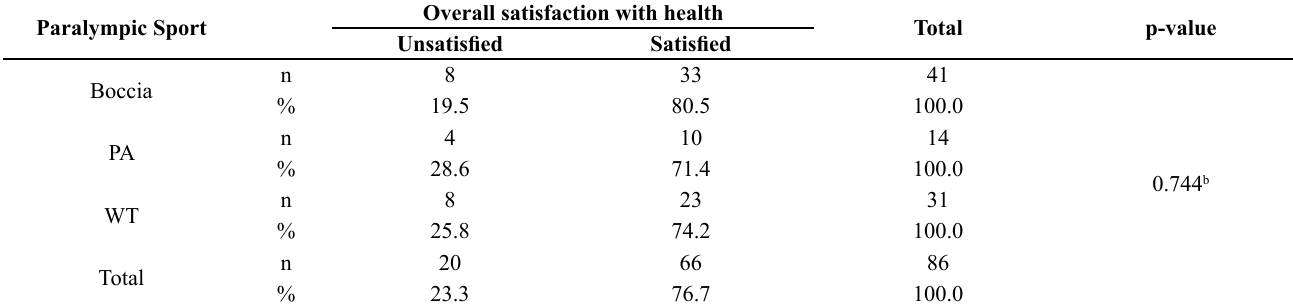
Table 3. Overall satisfaction with health among Paralympic Sport